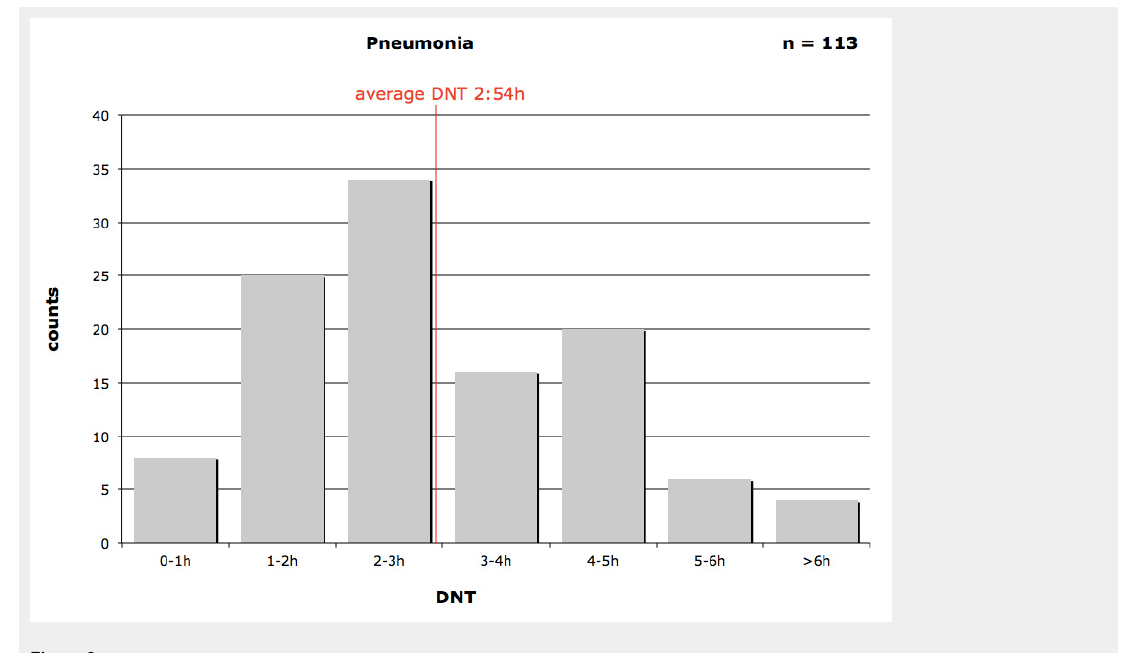
Figure 2 Door-to-needle-time (DNT) in community acquired pneumonia